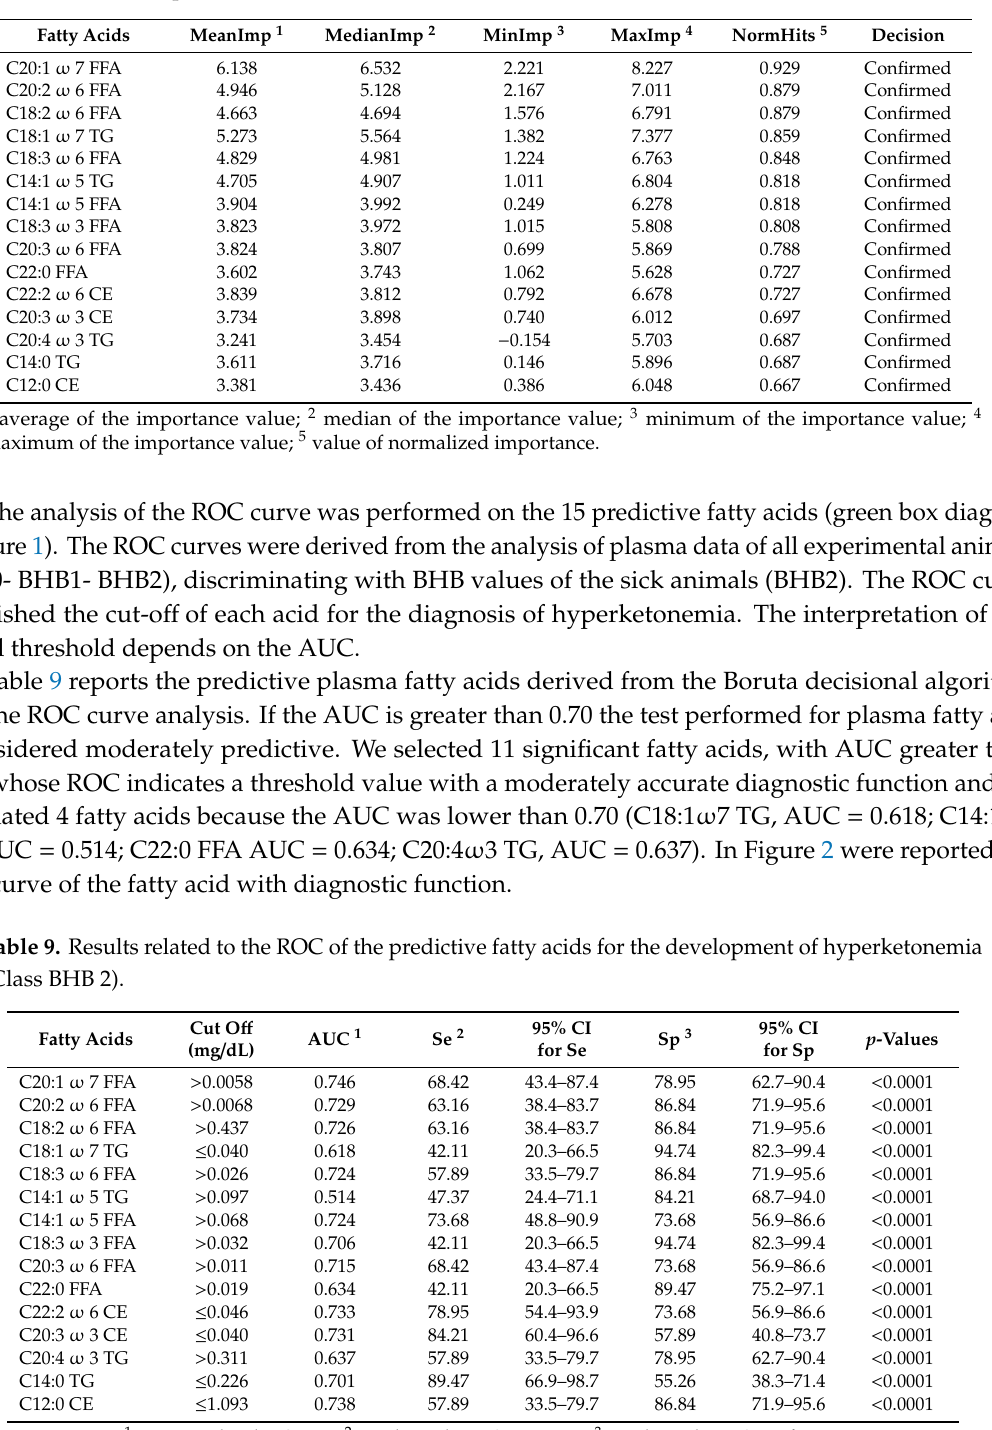
Table 8. Predictive fatty acids with relative mean, median, minimum value, maximum value, and normal value of importance.